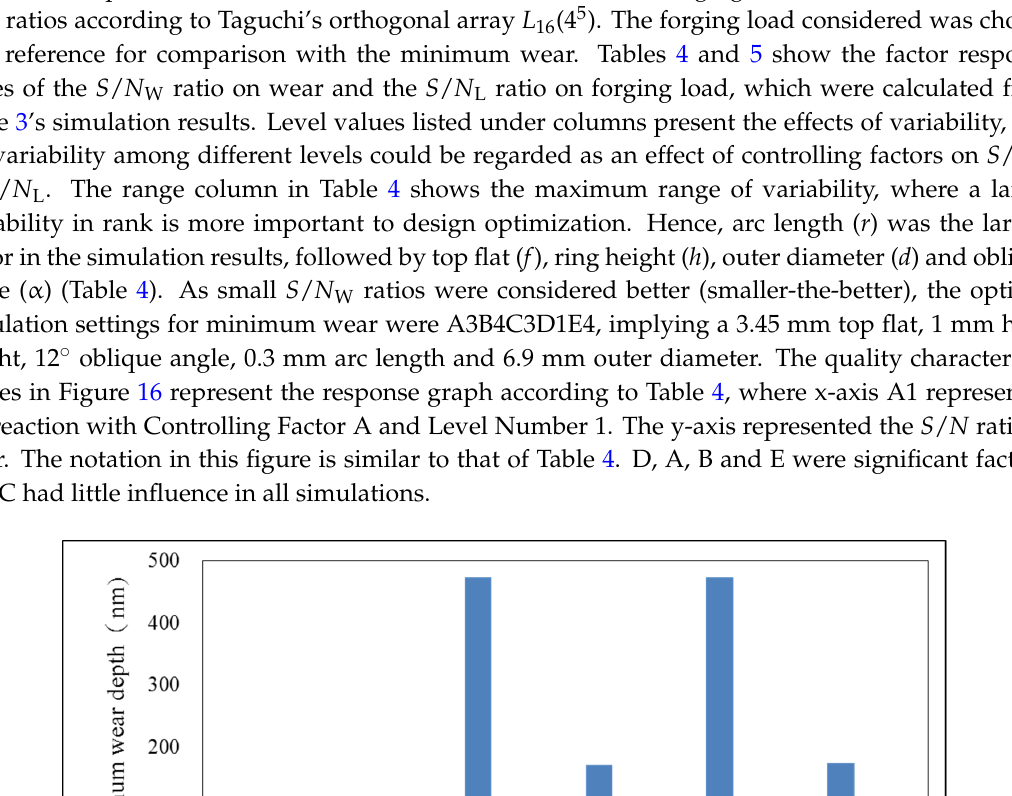
Figure 14. Velocity, effective stress and wear distribution of the sixth stage in 3D. ( a ) Velocity; ( b ) Effective stress; ( c ) Wear.